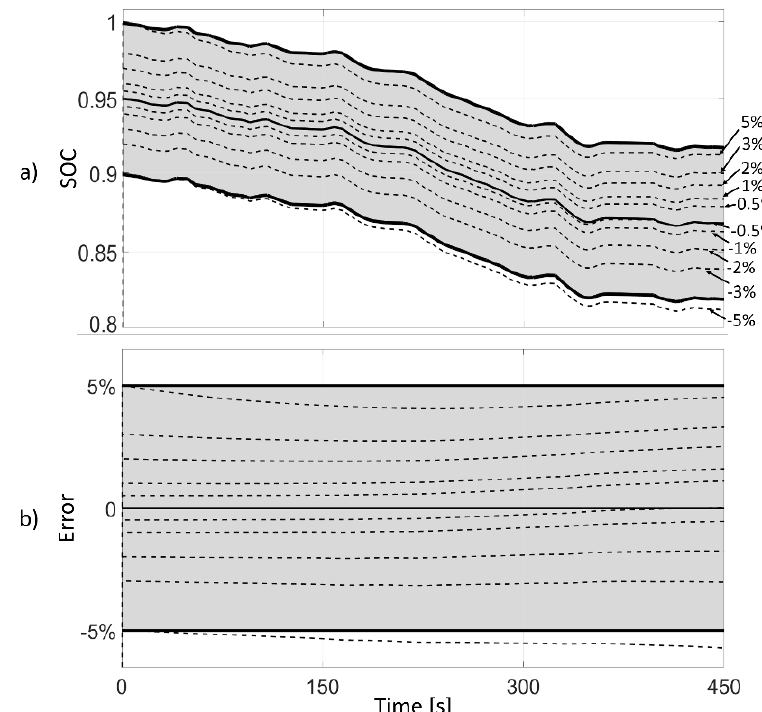
Figure 10. Robustness analysis to the initial SOC estimation inaccuracies. ( a ) Estimation output with error on the initial SOC ranging from − 5% to + 5%. ( b ) Error between the expected and the estimated SOC. In both plots, the grey area indicates the error tolerance region of ± 5%. The solid lines represent the expected SOC and the two tolerance thresholds. The dashed lines are the SOC estimations.